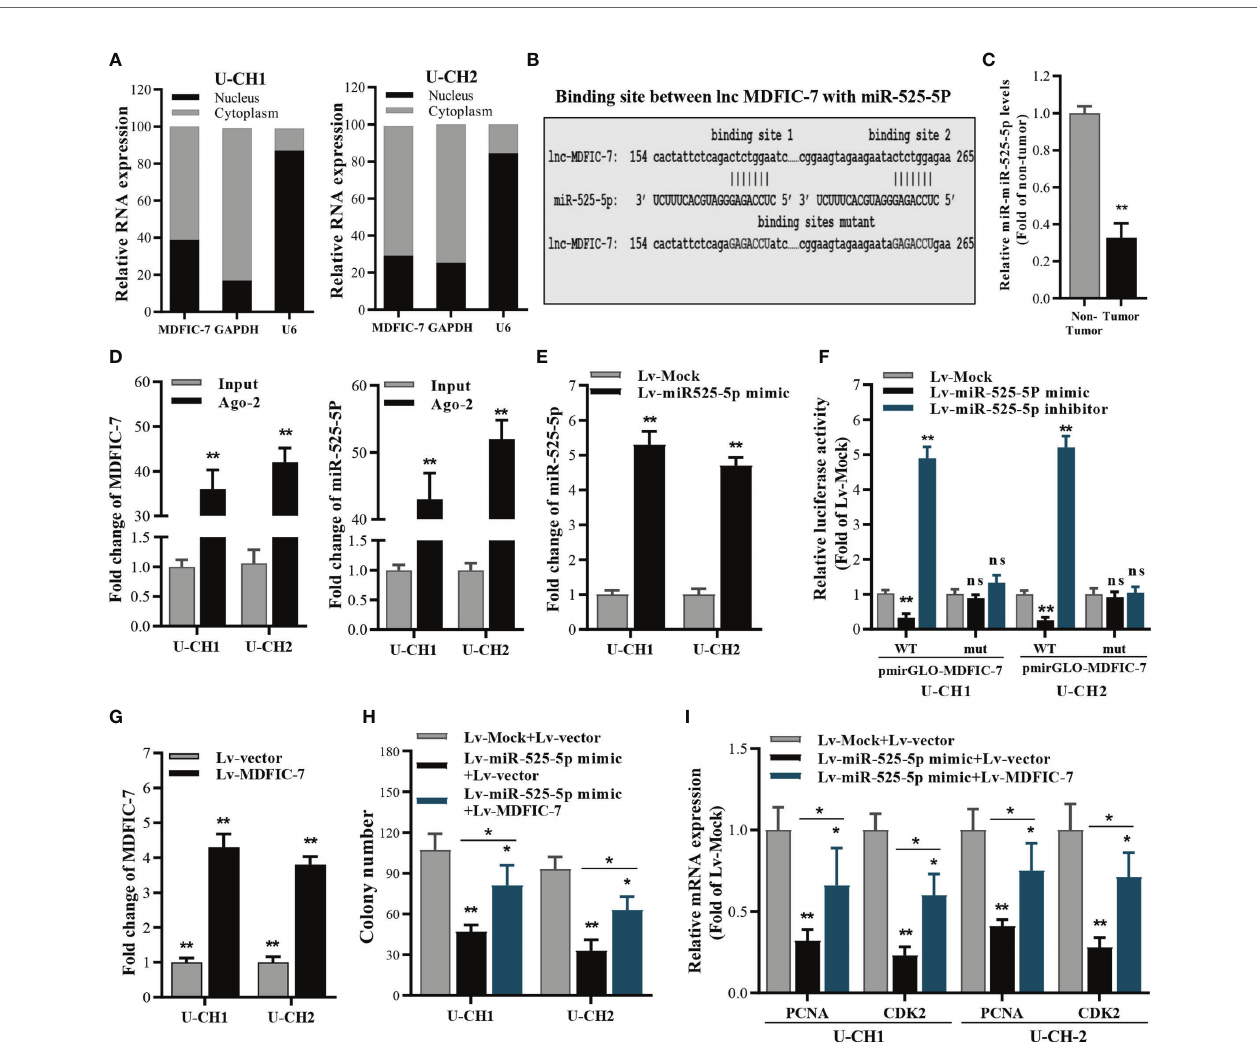
FIGURE 3 | LncRNA MDFIC-7 sponges with miR-525-5p. (A) qRT-PCR analysis of lncRNA MDFIC-7 in nuclear and cytoplasmic fractions. GAPDH mRNA and U6 were used as a cytoplasmic control and nuclear control, respectively. (B) The predicted binding site between lncRNA MDFIC-7 and miR-525-5p. (C) qRT-PCR analysis of miR-525-5p in clinical chordoma tissues. ** p < 0.01 vs . non-tumor. (D) qRT-PCR analysis on the expression of lncRNA MDFIC-7 and miR-525-5p after anti-Ago2-mediated RIP assay in U-CH1 and U-CH2 cells. ** p < 0.01 vs . input. (E) qRT-PCR analysis of miR-525-5p in U-CH1 and U-CH2 cells after infection with Lv-miR525-5p mimic. ** p < 0.01 vs . Lv-mock. (F) Dual luciferase reporter assay in chordoma cells transfected with pmirGLO-MDFIC-7-wt or pmirGLO-MDFIC-7-mut together with mock, miR-525-5p mimic or miR-525-5p inhibitor. ** p < 0.01, ns, no signi fi cant differences vs . Lv-mock. (G) qRT-PCR analysis of lncRNA MDFIC-7 in U-CH1 and U-CH2 cells after infection with Lv-MDFIC-7. ** p < 0.01 vs . Lv-vector. (H) Colony formation assay in chordoma cells infected with Lv-miR525-5p or co-infected with Lv-miR525-5p and Lv-MDFIC-7. * p < 0.05 vs . Lv-miR-525-5p+Lv-MDFIC-7, ** p < 0.01 vs . Lv-mock+Lv-vector. (I) qRT-PCR of PCNA and CDK2 mRNAs in U-CH1 and U-CH2 cells after infection with the indicated lentivirus for 48 h. * p < 0.05 vs . Lv-miR-525-5p+Lv-MDFIC-7, ** p < 0.01 vs .